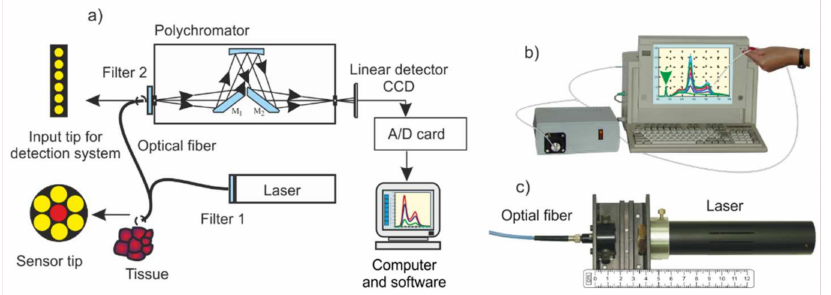
Figure 1. Fiberoptic fluorescence analyzer: ( a ) optical scheme, ( b ) view, ( c ) laser with input optics.